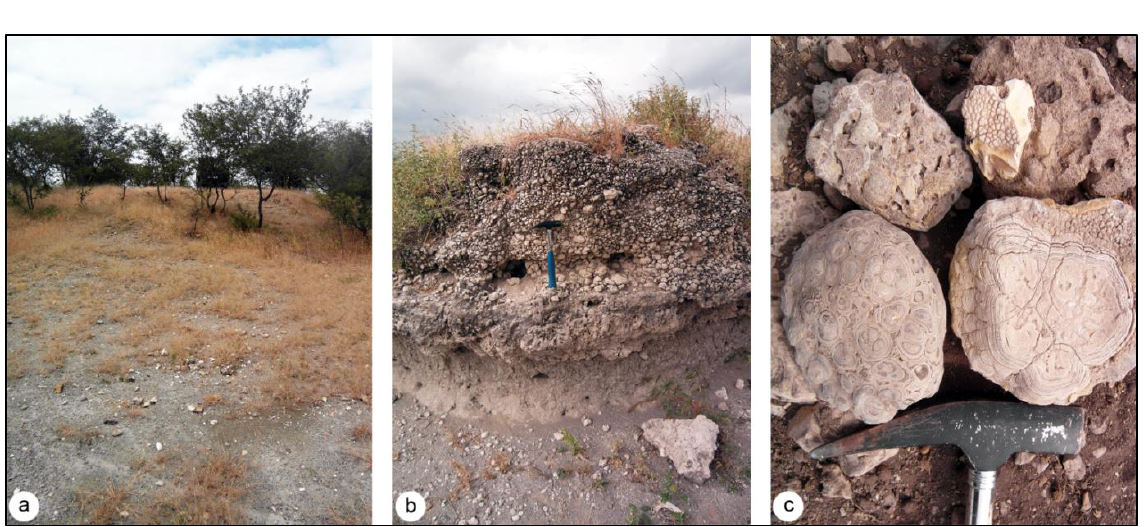
Figure 2. ( a ) Distinct paleo-shoreline (Lon. 36.006°, Lat. −3.629°); ( b ) Shoreline section (Lon. 35.909°, Lat. −3.396°); ( c ) Stromatolites and oncolites (Lon. 35.934°, Lat. −3.444°); Compare with Figure